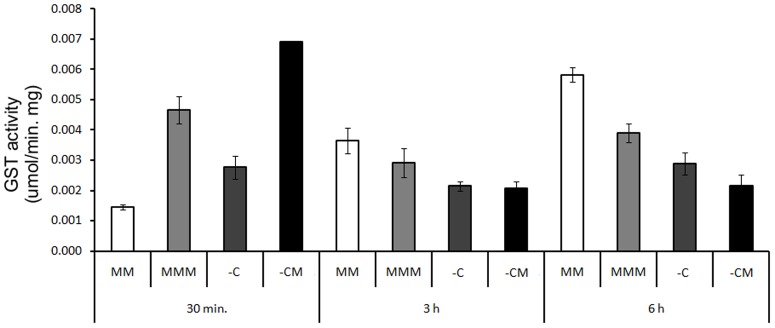
GST activity of E. coli DH5-α in MM, and in the MMM, -C, and -CM treatments, at periods of 30 min. 3 h and 6 h, respectively.LSD = 0.000398 for all pairwise comparison.